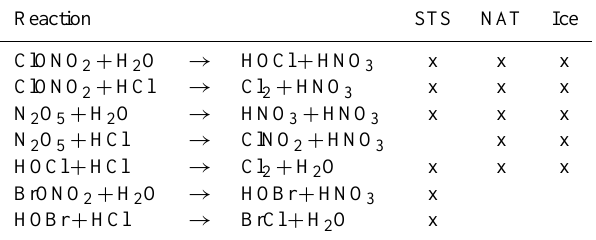
Table 4. List of heterogeneous reactions. The cloud types on which the reactions happen are indicated (STS=supercooled ternary solu- tion, NAT=nitric acid trihydrate). Reaction STS NAT